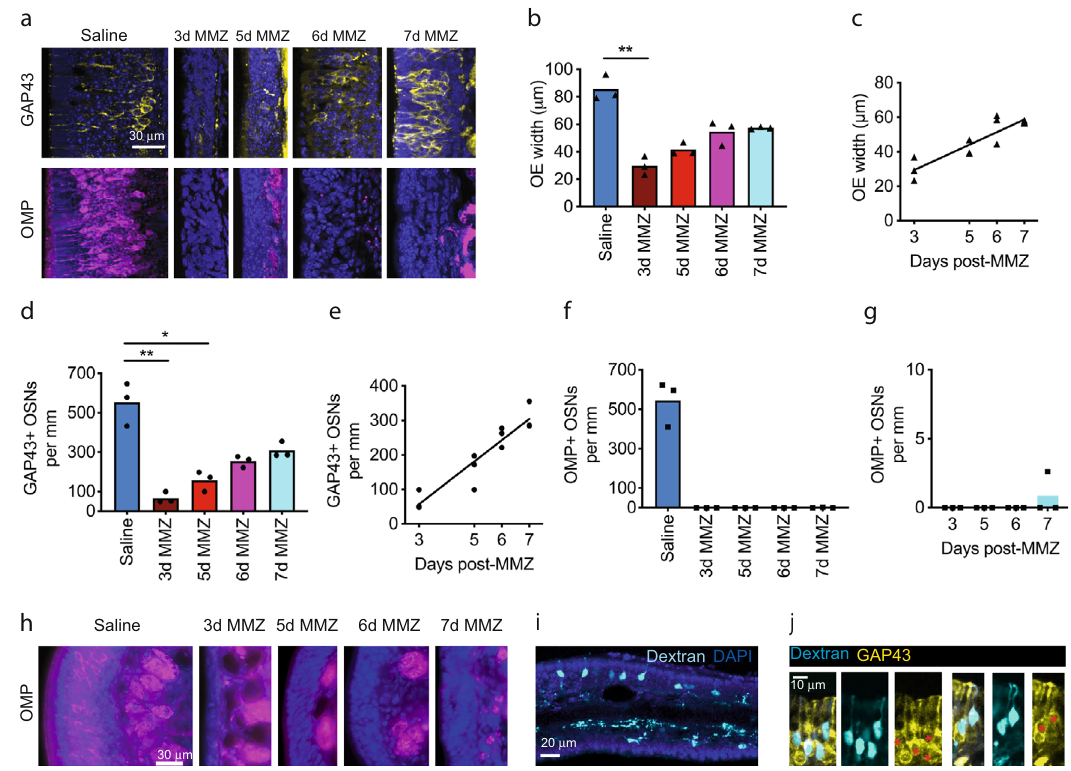
Fig. 9 | The olfactory epithelium contains immature but not mature OSNs at earlytimepointsaftermethimazoleadministration.a MIPsof2-photonz-stacks of coronal OE sections stained for GAP43 or OMP. b OE width is signi fi cantly reduced 3 days post-MMZ compared to saline-injected mice (One-way ANOVA on Ranks. P <0.001,Kruskal – Wallisstatistic=12.4.Dunn ’ smultiplecomparisonstests. 3-day, P =0.004, Z =3.29; 5d, P =0.071, Z =2.37; 6d, P =0.94, Z =1.19; 7d, P =0.68, Z =1.37; vs. saline. n =3 mice per group). c OE width increases linearly between 3 and7dayspost-MMZ(Linearregression. P <0.001,R 2 =0.80, n =3micepergroup). d GAP43+OSN linear density is signi fi cantly reduced at 3 and 5 days post-MMZ compared to saline-injected mice (One-way ANOVA on Ranks: P <0.001, Kruskal – Wallis statistic=13.4. Dunn ’ s multiple comparisons tests. 3d MMZ, P =0.005, Z =3.24;5dMMZ, P =0.048, Z =2.51;6dMMZ, P =0.40, Z =1.65;7dMMZ, P =1.00, Z =0.82; vs. saline-injected mice. n =3 mice per group). e GAP43+OSN